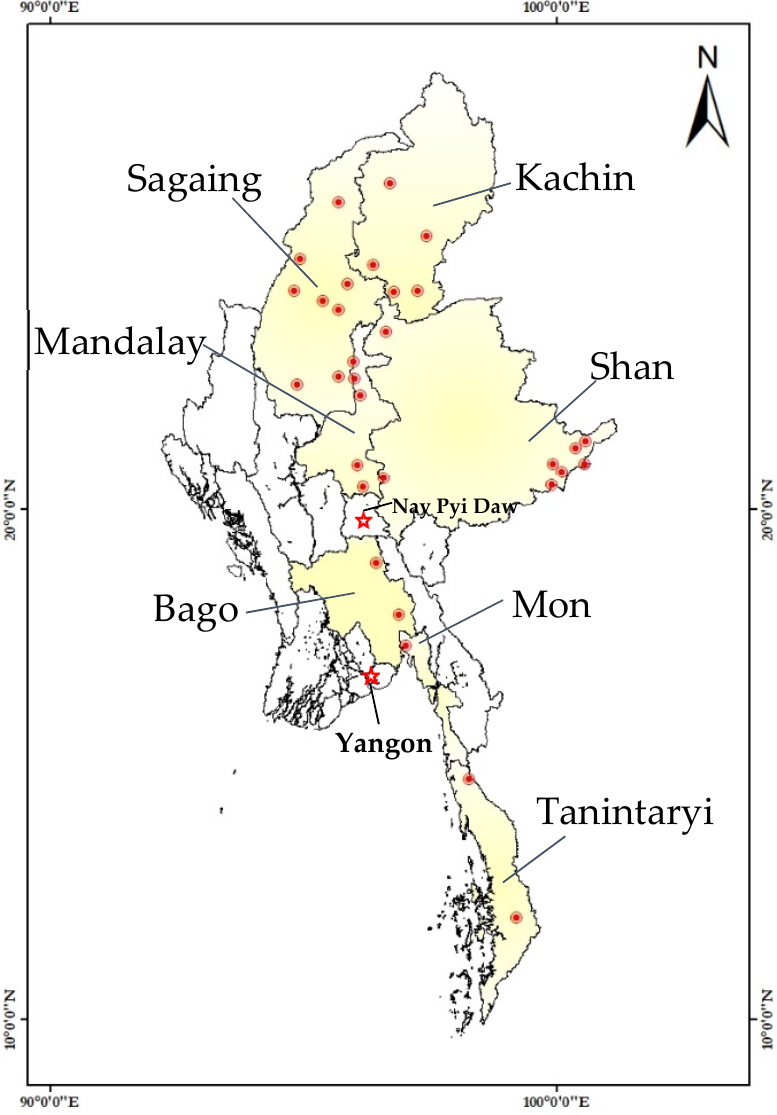
Figure 2. Distribution of artisanal and small-scale gold mining (ASGM) activities in the states and regions of Myanmar by township.